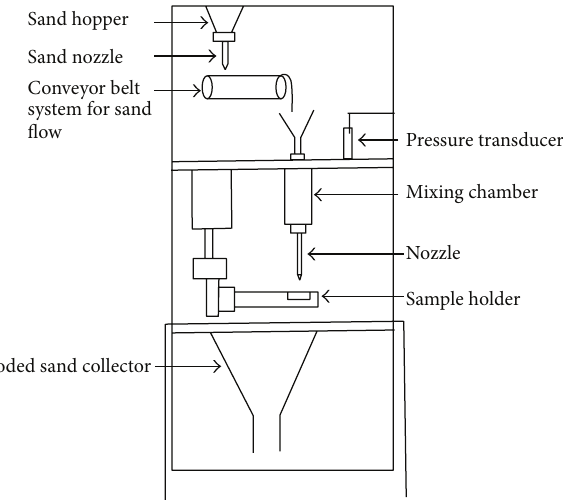
Figure 2: Solid particle erosion test setup.